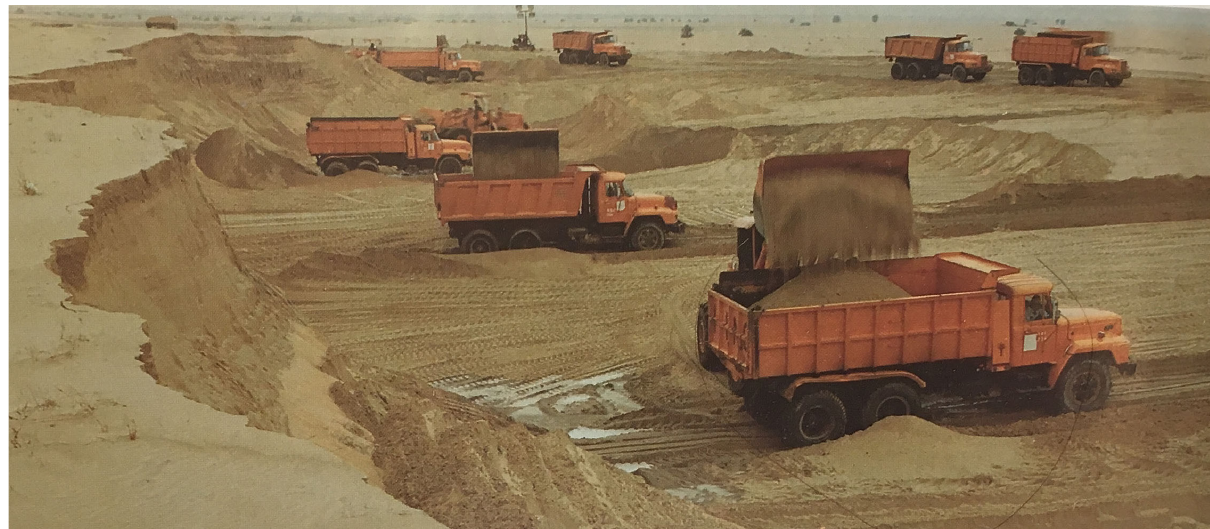
Fig. 4 Earthmoving trucks rearrange tons of the desert substrate, preparing the ground for the new cities. Source: The Royal Commission for Jubail and Yanbu, Madinat Al-Jubail Al-Si- naiyah: Mokhtat Al-Mantikah Al-Sakaniyah (Riyadh: the Royal Commission,